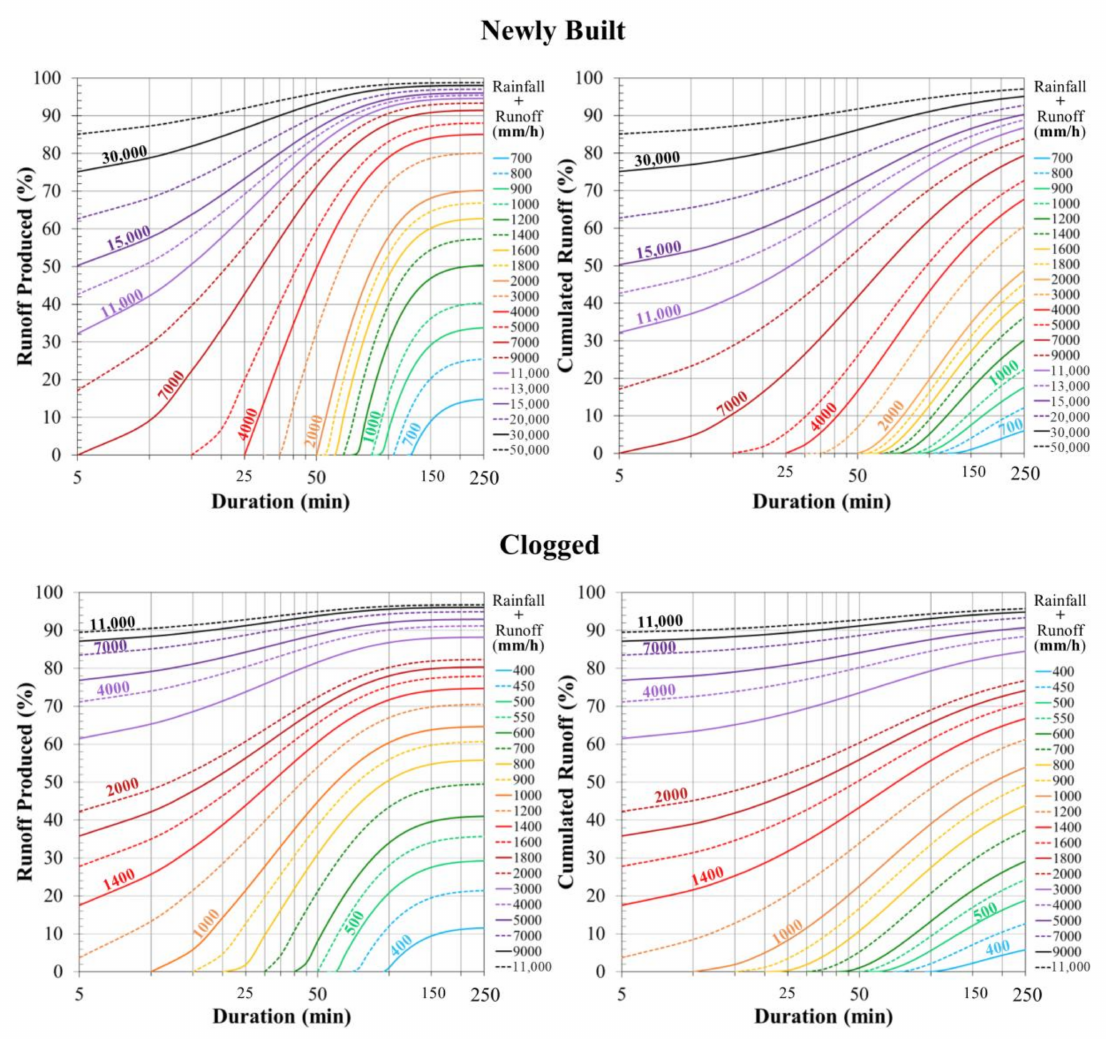
Figure 6. Predicted runoff production ( left ) and cumulated runoff ( right ) depending on storm events duration, for various stationary rainfall events in clogged and newly built scenarios. The different lines represent the equivalent rainfall intensity of theoretical storm